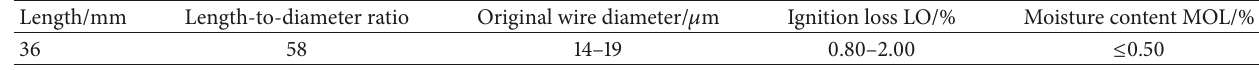
Table 1: Alkali-resistant glass fiber characteristics parameters.